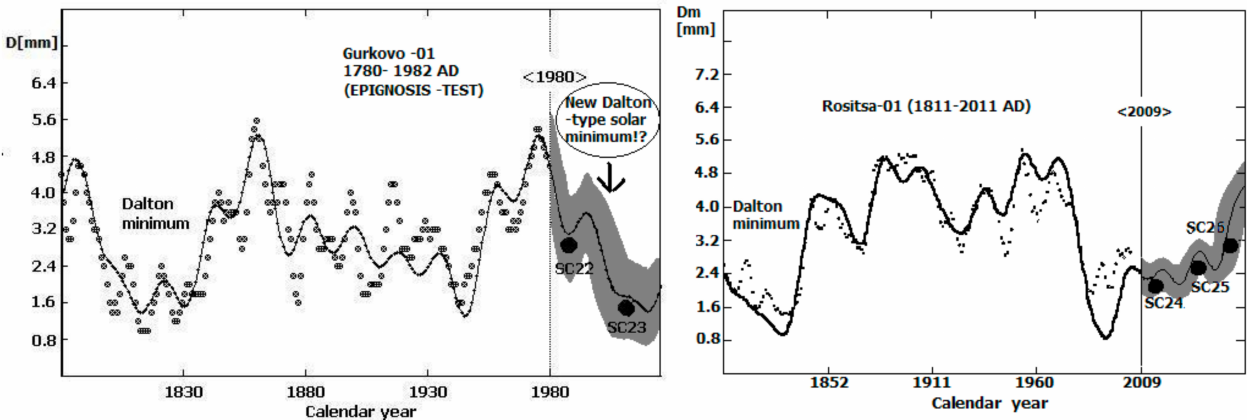
Figure 8. Left : Kinematic model of the time series of D m [mm] for the Gurkovo-01 sample and its extrapolation through 2010 AD; right : Kinematic model of the time series of D for the Rositsa-01 sample and its extrapolation through 2045 AD